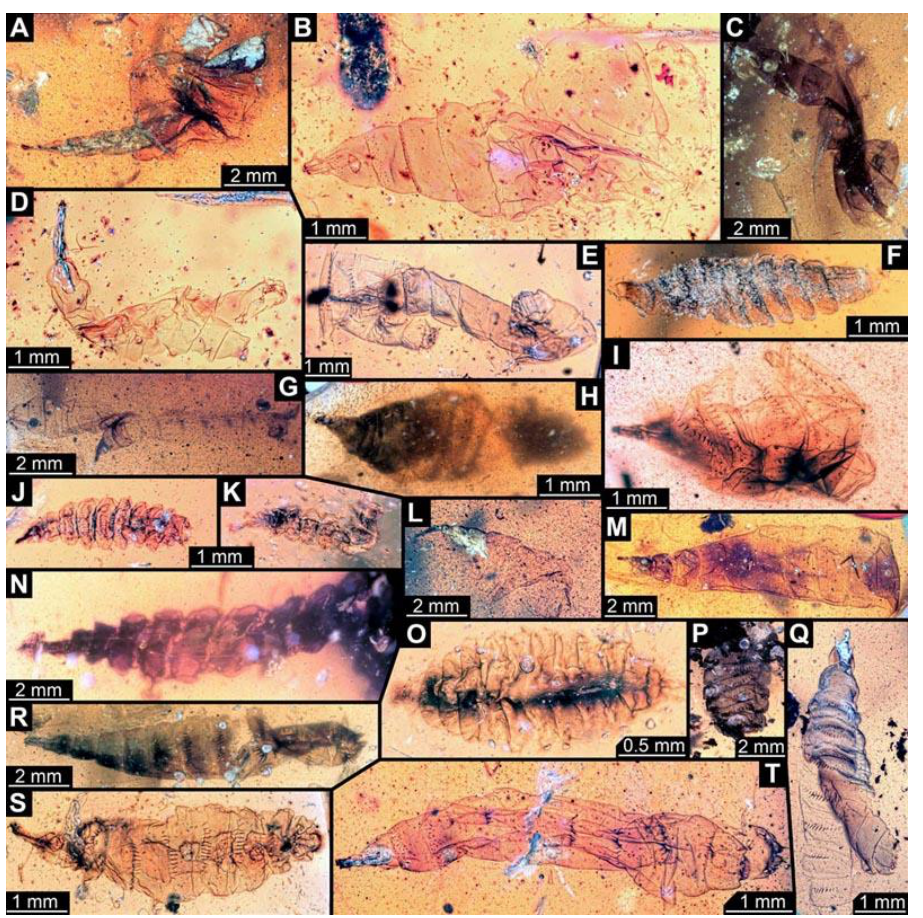
Figure 10. Several fossil larvae. ( A ). PED 0850. ( B ). PED 0873-1. ( C ). PED 1018. ( D ). PED 0873-2. ( E ). PED 0962. ( F ). PED 1137. ( G ). PED 1560. ( H ). PED 0987. ( I ). PED 1167. ( J ). PED 0921. ( K ). PED 0934. ( L ). PED 1001. ( M ). PED 1140. ( N ). PED 0990. ( O ). PED 1109. ( P ). PED 1279. ( Q ). PED 1174. ( R ). PED 1014. ( S ). PED 1025. ( T ). PED 1044. (46) PED 0873-2: Specimen crumpled and torn apart from mesothorax to trunk end (Figure 10D). Surface structure apparent. Head capsule stretched. Short spine-like setae on thorax segments and longer ventral spine-like setae on abdomen segments well developed. No measurements of body could be recorded. Dimensions: head capsule length 1.71 mm, head capsule width 0.27 mm. (47) PED 0962: Specimen separated into ventral and dorsal halves (Figure 10E). Surface structure apparent. Head capsule well preserved. Paired anterior spiracles visible on prothorax. Short spine-like setae on thorax segments and longer ventral spine-like setae on abdomen segments well developed. No measurements of the body could be recorded. Dimensions: head capsule length 0.69 mm, head capsule width 0.14 mm. (48) PED 1137: Specimen only accessible in dorsal view, concealed by numerous